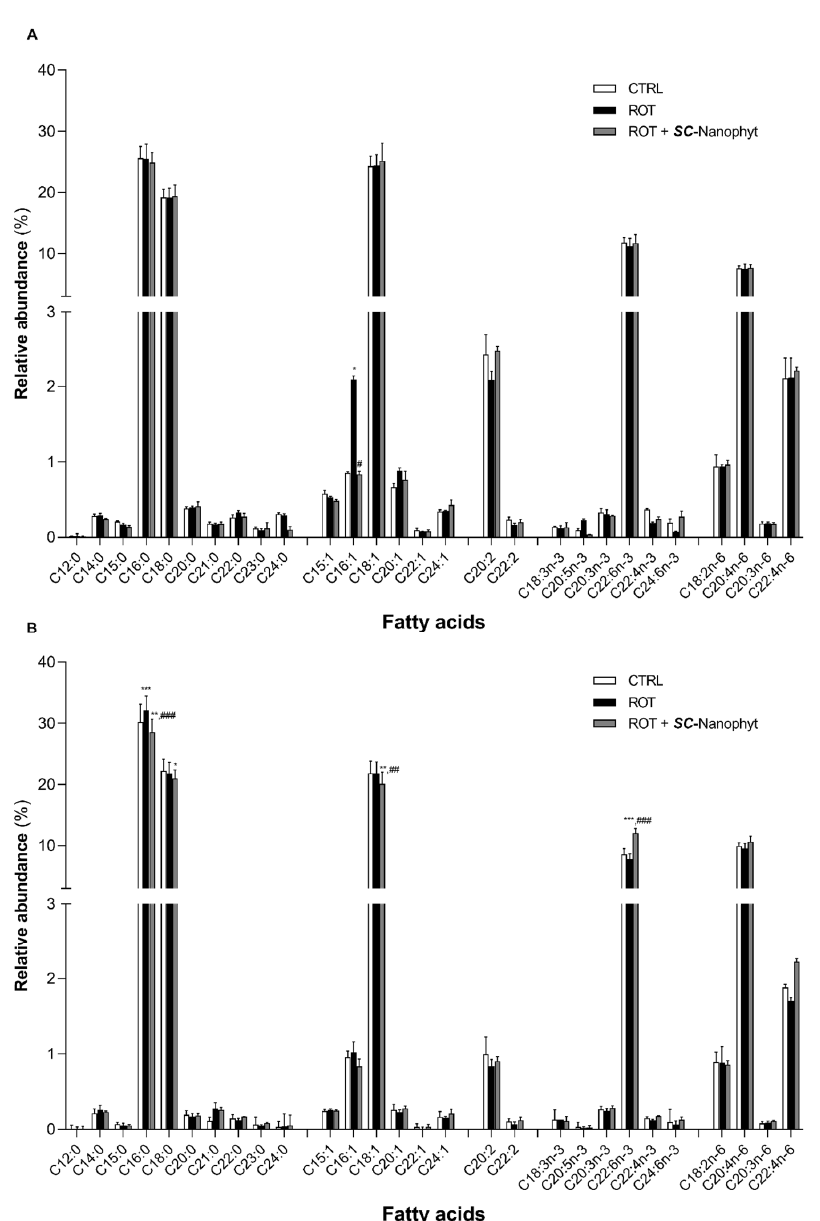
Figure 6. Fatty acid profile of phospholipid extracts obtained from mitochondria-rich fraction from BG-Cereb ( A ) and C-Cortex ( B ) brain portions of CTRL, ROT and ROT + SC -Nanophyt groups (CTRL: white bars; ROT: black bars; ROT + SC -Nanophyt: grey bars): C12:0 = lauric acid, C14:0 = myristic acid, C15:0 = pentadecanoic acid, C16:0 = palmitic acid, C18:0 = stearic acid, C20:0 = arachidonic acid, C21:0 = heneicosanoic acid, C22:0 = docosanoic acid, C23:0 = tricosanoic acid, C24:0 = lignoceric acid, C15:1 = pentadecenoic acid, C16:1 = palmitoleic acid, C18:1 = oleic acid, C20:1 = eicosenoic acid, C22:1 = docosenoic acid, C24:1 = nervonic acid, C20:2 = eicosadienoic acid, C22:2 = docosadienoic acid, C18:3n-3 = α -linolenic acid, C20:5n-3 = eicosapentaenoic acid (EPA), C20:3n-3 = eicosatrienoate acid, C22:6n-3 = docosahexanoic acid (DHA), C22:5n-3 = docosapentaenoic acid (DPA), C22:4n-6 = docosatetraenoate, C24:6n-3 = tetracosahexaenoic acid, C18:2n-6 = linoleic acid, C20:4n-6 = arachidonic acid (AA), C20:3n-6 = dihomo- γ -linolenic acid (DGLA). Error bars represent SEM for n = 5 independent experiments using five animals in each one. *, **, *** Significantly different from CTRL group, with p ≤ 0.05, p < 0.01 and p < 0.001, respectively. # , ## , ### Significantly different from ROT group, with p ≤ 0.05, p < 0.01 and p < 0.001, respectively.